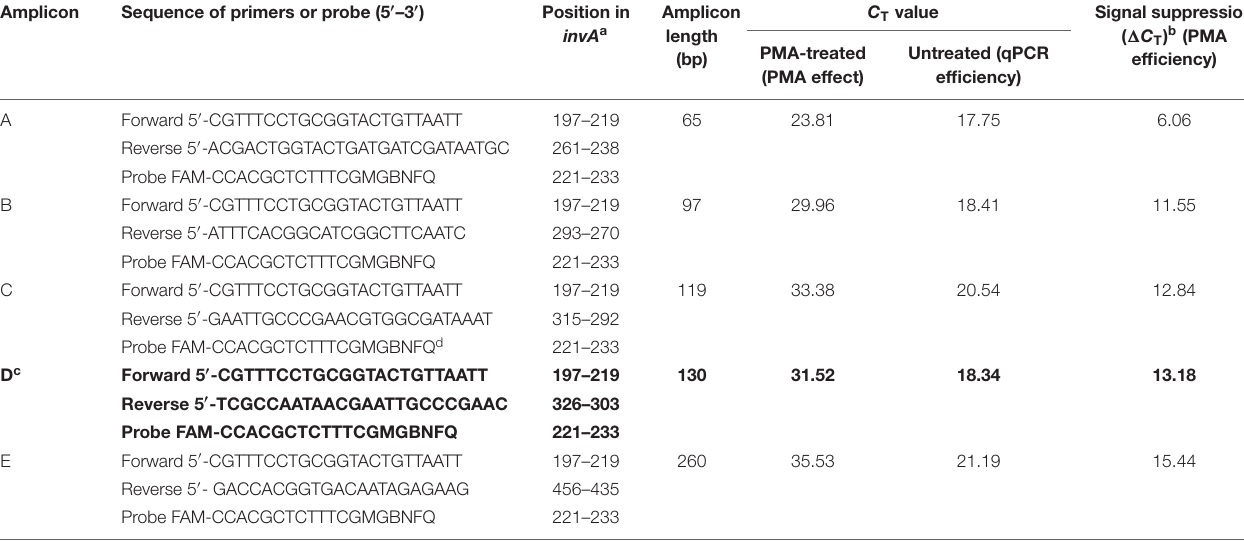
TABLE 3 | Effect of amplicons of different length on signal suppression of Salmonella dead cells by PMA-qPCR. Amplicon Sequence of primers or probe (5 (cid:48) –3 (cid:48)